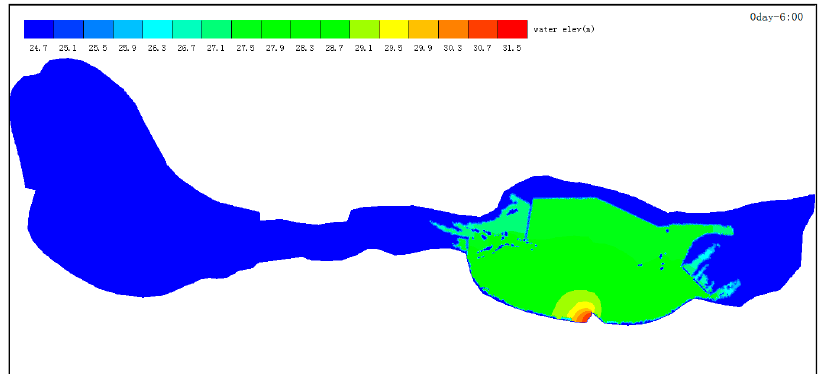
Figure 4. Finite volume Ω , where x̄ is left side of the boundary, ȳ is right side of the boundary, f (cid:2896)(cid:2902) is flux and Φ is the angle in the normal direction of the boundary. ).